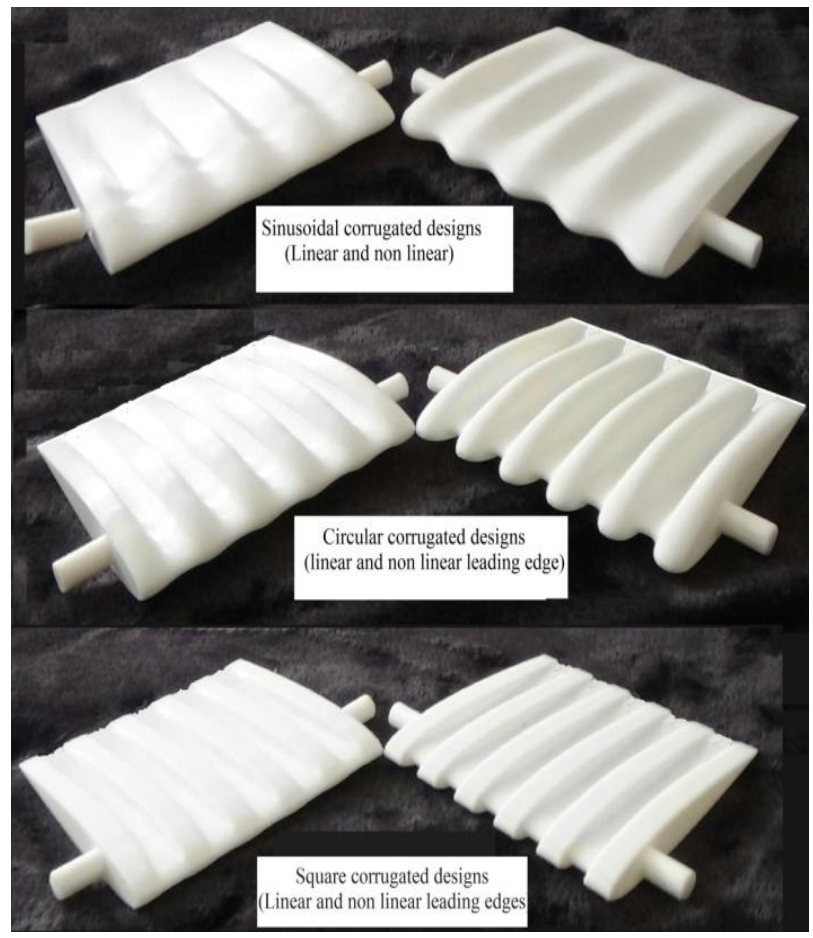
Figure 7. The fabricated corrugated hinges by 3d Printer, sinusoidal, circular, and square profile geometry.